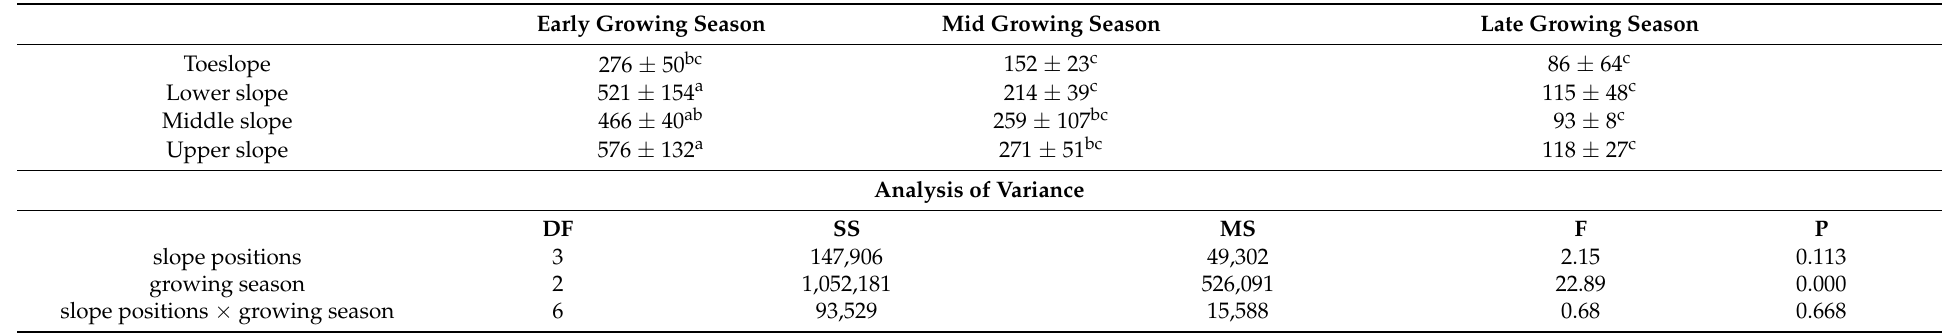
Table 4. Soil cumulative N 2 O emissions (g ha − 1 ) from different slope positions during early (22 May to 6 June), mid (21 June to 7 August), and late growing season (20 August to 11 October) during 2019 from Research North farm. Means sharing different letters are significantly different from each other (LSD, p <